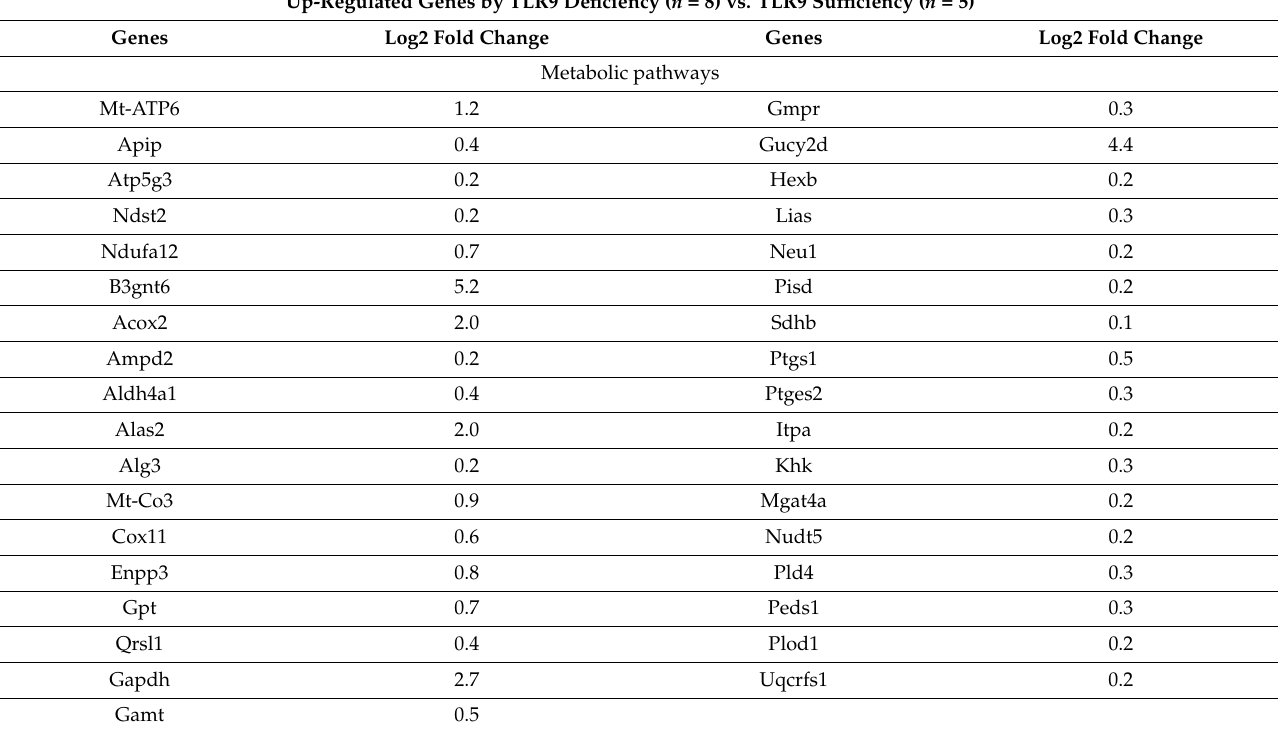
Table 4. List of genes in selected pathways altered by TLR9 deficiency (vs. TLR9 sufficiency) in mouse lung macrophages treated with palmitic